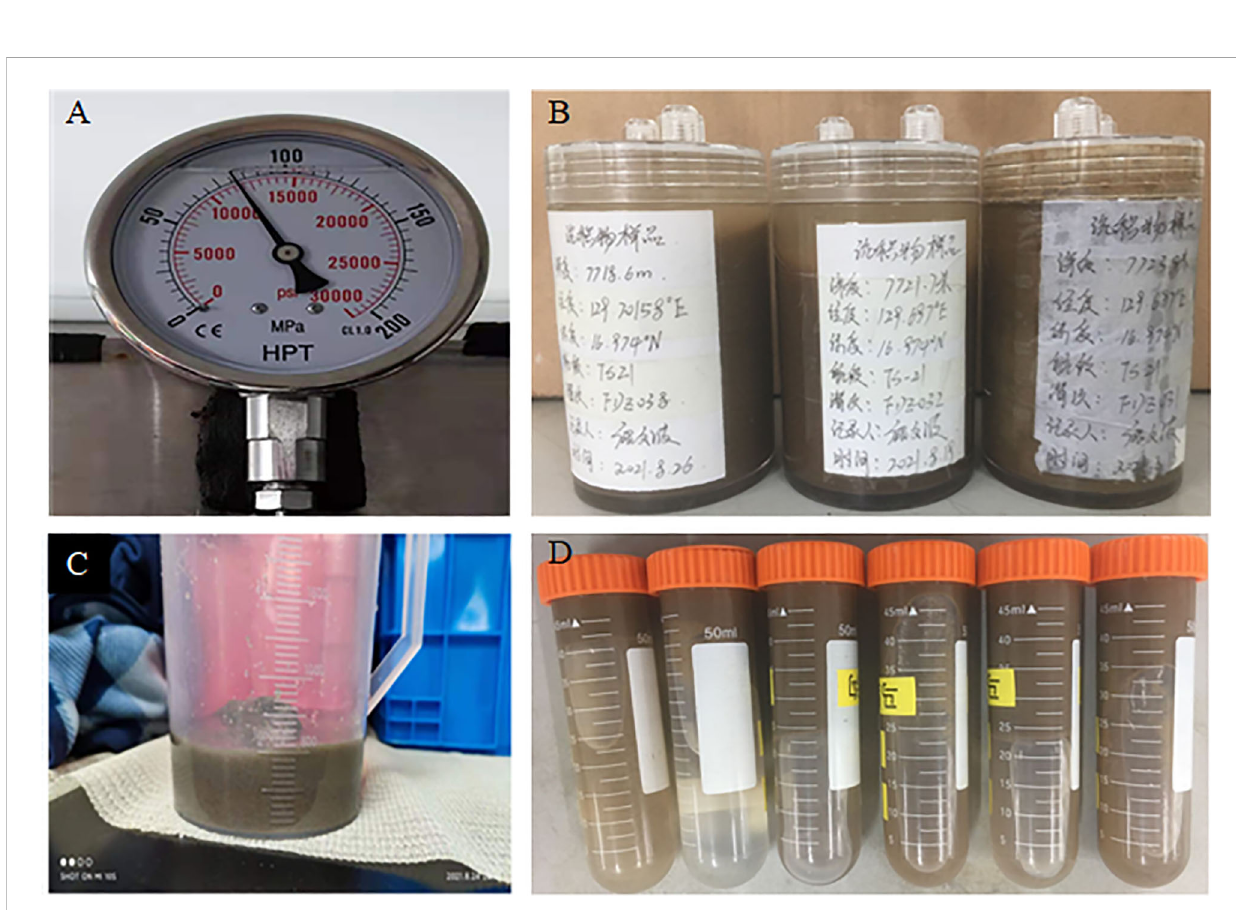
FIGURE 12 Sediment sample obtained, (A) the fi nal pressure of the samples in the sampler, (B – D) the sediment samples obtained during the sea